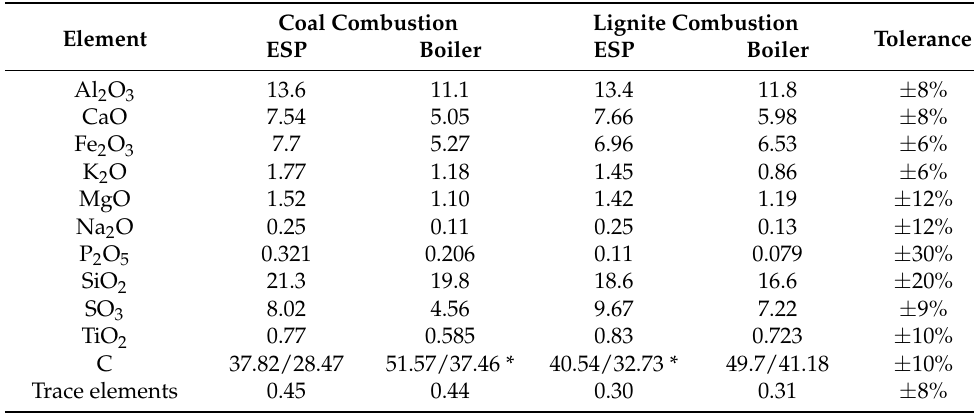
Table 5. The major elements of fly ash chemical composition (mass %, dry).